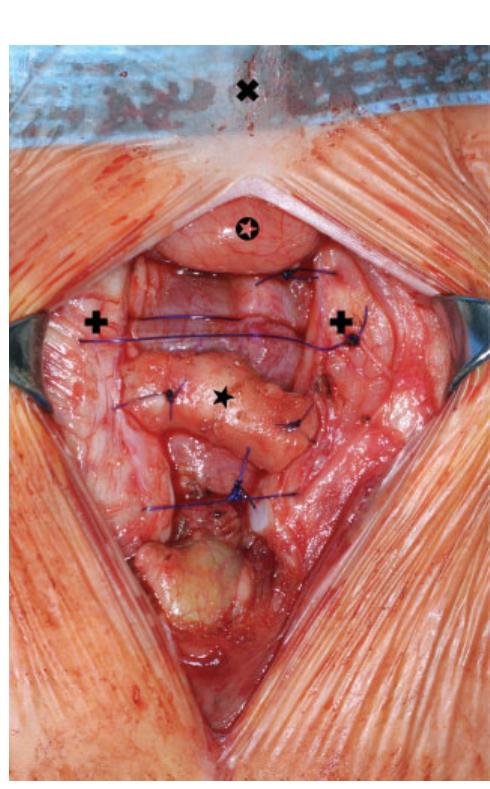
Fig. 1 Presentation of the strand with extension from the xiphoid process to the umbilical cord.